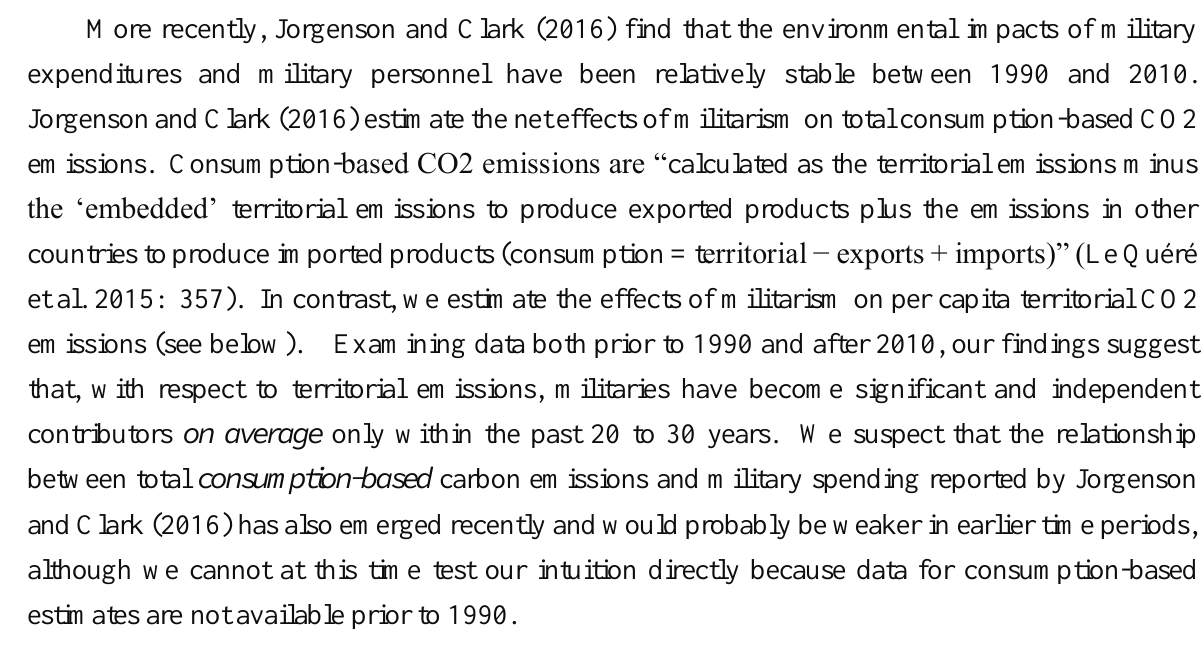
Table 1. Number of Observations per Country